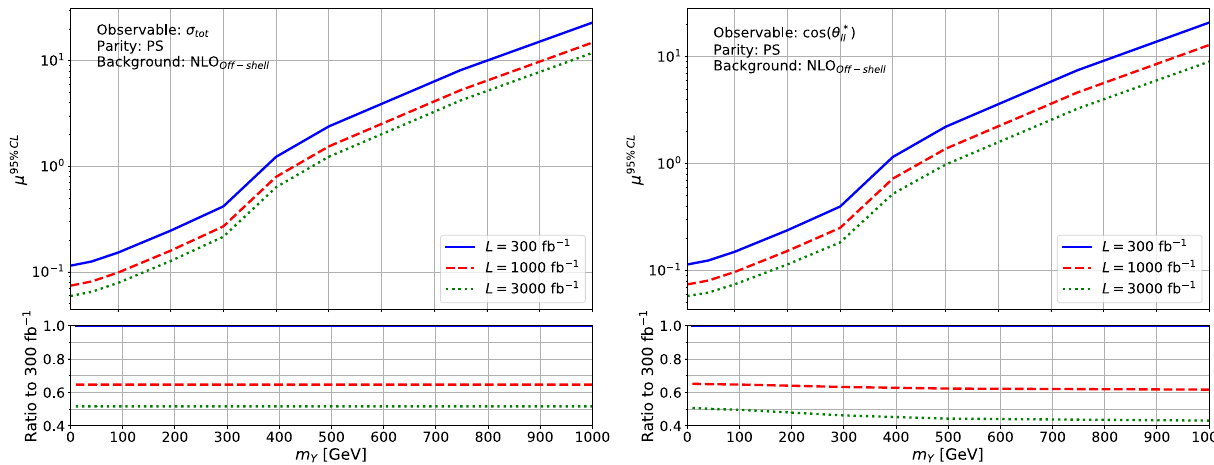
Fig. 18 Comparison of signal strength exclusion limits for several different luminosities for the pseudoscalar mediator scenario computed with NLO Off-shell backgrounds. In the lower panels we present the ratios to the limits obtained using a luminosity of L = 300 fb −